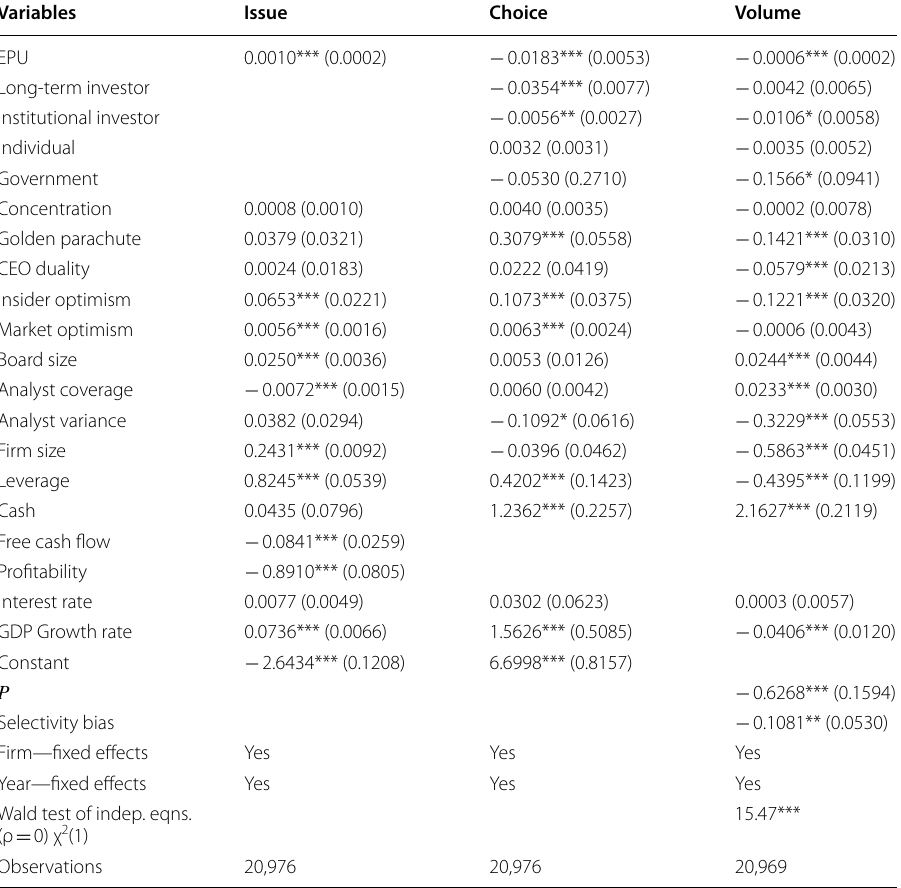
Table 5 Empirical estimations based on the Heckman three-stage ordered probit model with firm- fixed effects and year-fixed effects and robust standard